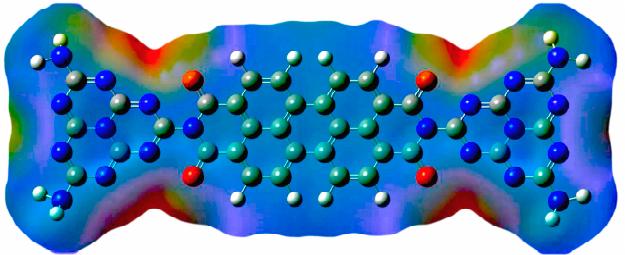
Figure 7. Optimized ESP surface distribution of the g-CN-PTCDA model.